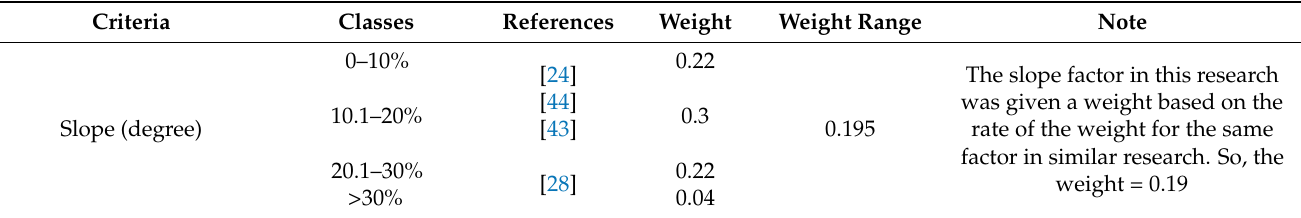
Figure 4. Variables affecting urban expansion in Irbid. Table 2. Criteria classes and weighting.